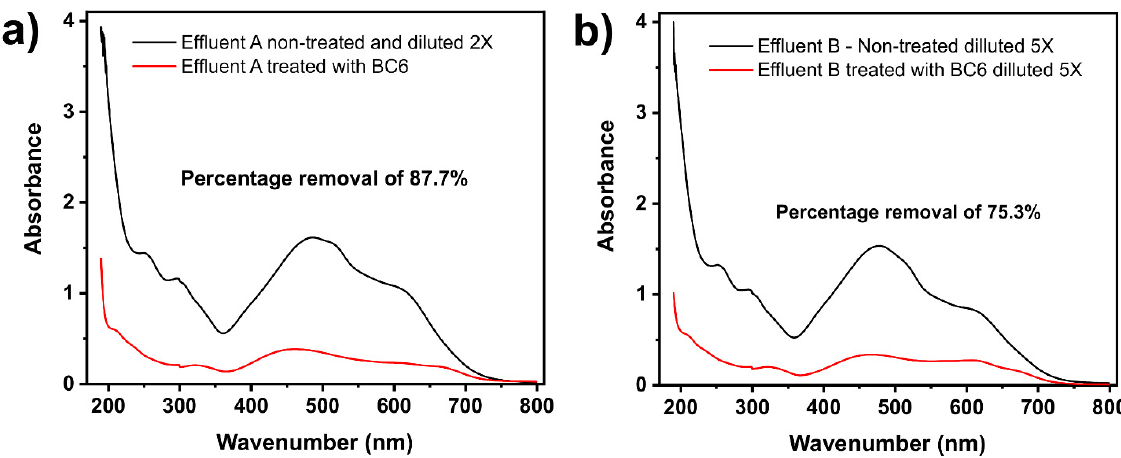
Figure 14. Spectra of effluents A ( a ) and B ( b ) treated and non-treated by BC10 .